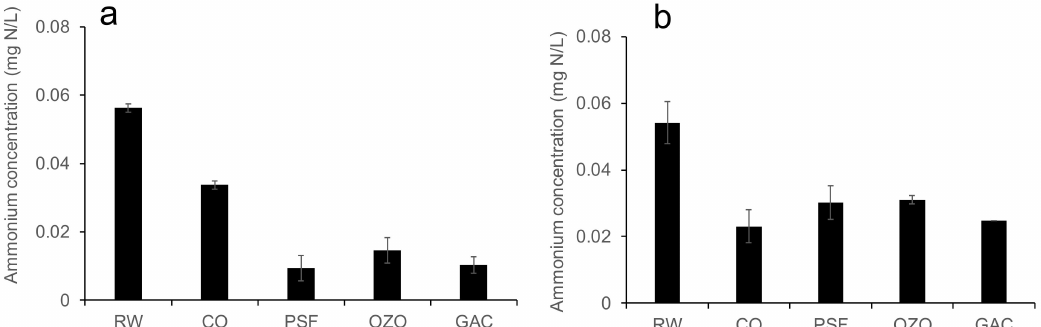
Figure 1. The ammonium concentration in the raw water and the effluent of the water purification processes in the two samplings (i.e., without prechlorination ( a ) and with prechlorination ( b )). RW: raw water, CO: coagulation/sedimentation, PSF: primary sand filtration, OZO: ozonation, GAC: granular activated carbon, and error bar: the standard